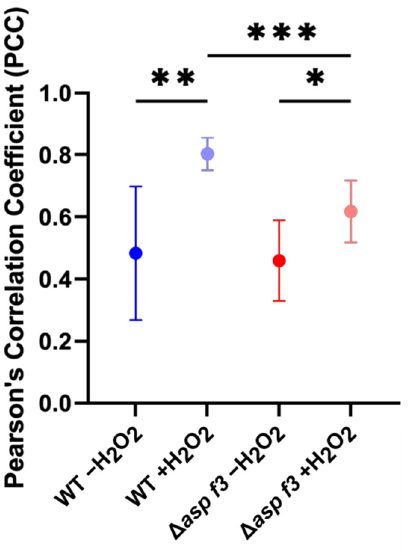
Figure 7. Quantification of co-localization of DAPI and AfYap1 VENUS dependent fluorescence signals. Pearson’s correlation coefficient (PCC) for DAPI and AfYap1 VENUS co-localization calculation in the presence and absence of H 2 O 2 in the wild type and ∆ asp f3 background strains. The data represents the mean and standard deviation from at least three independent experiments (n ≥ 3). Significant differences calculated by Student’s t-test are shown as *: p < 0.05; **: p < 0.01; ***: p < 0.001.